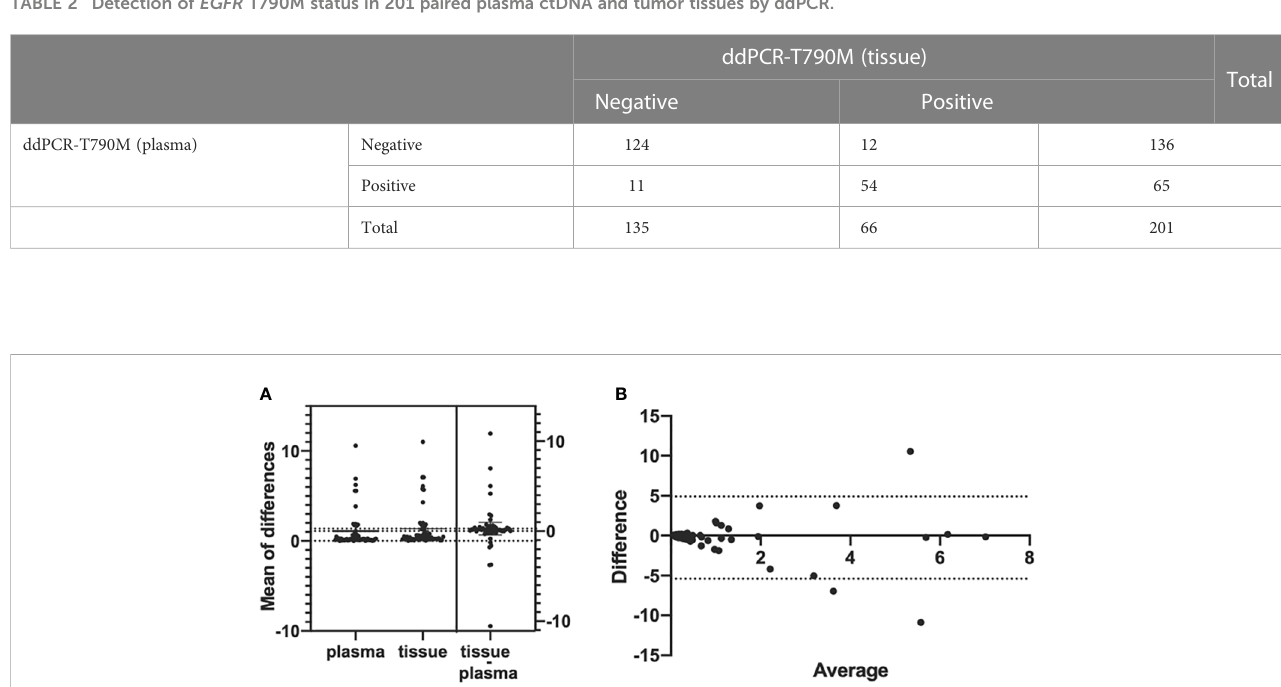
TABLE 2 Detection of EGFR T790M status in 201 paired plasma ctDNA and tumor tissues by